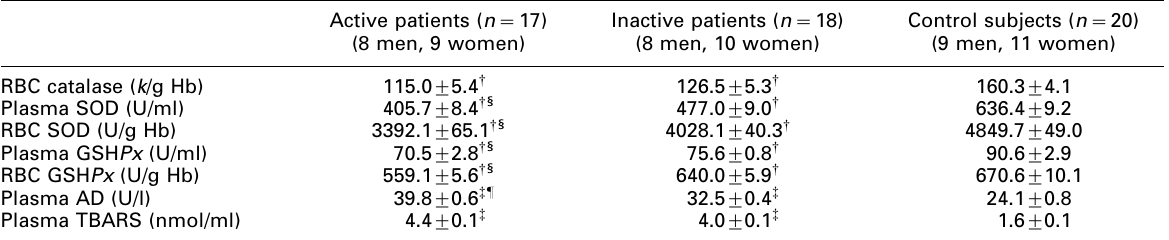
Table 3. Adenosine deaminase, thiobarbituric acid-reactive substances, superoxide dismutase, glutathione peroxidase and catalase activities in red blood cells or plasma of patients with Behc¸et’s disease and healthy control volunteers: statistical analysis